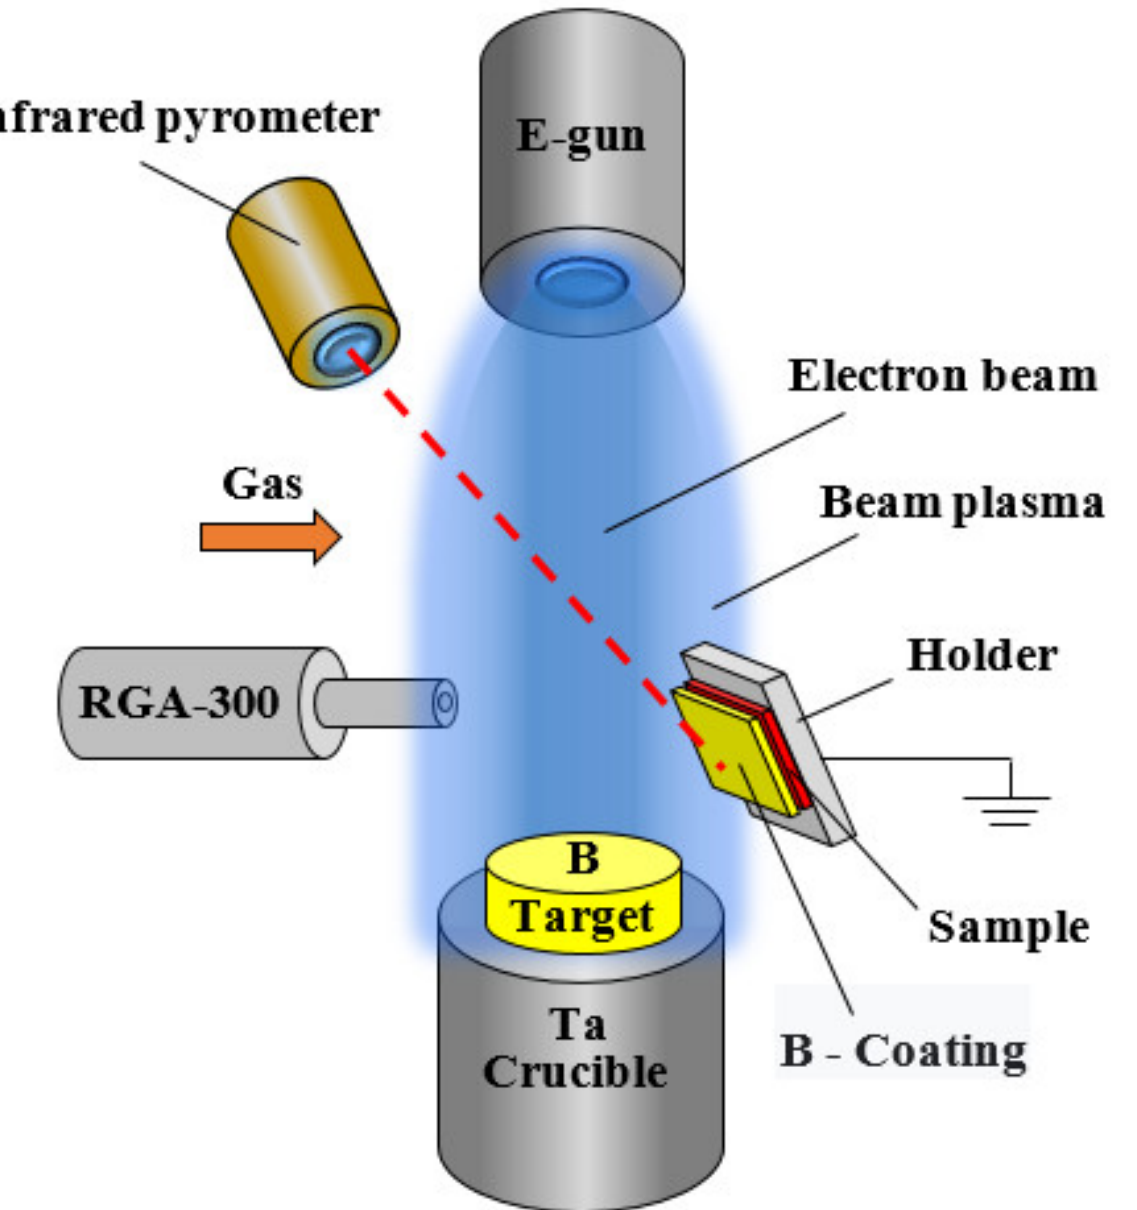
Figure 1. Schematic of the electron-beam synthesis of boron-based coatings.